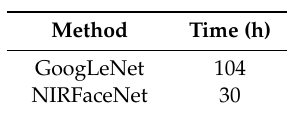
Table 6. Training times of CNN-based methods.